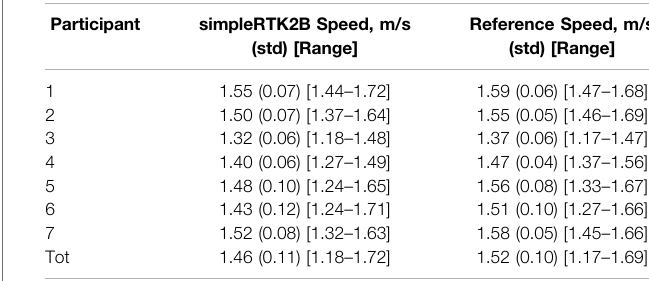
TABLE 2 | Walking speed values obtained from the RTK and the reference systems.